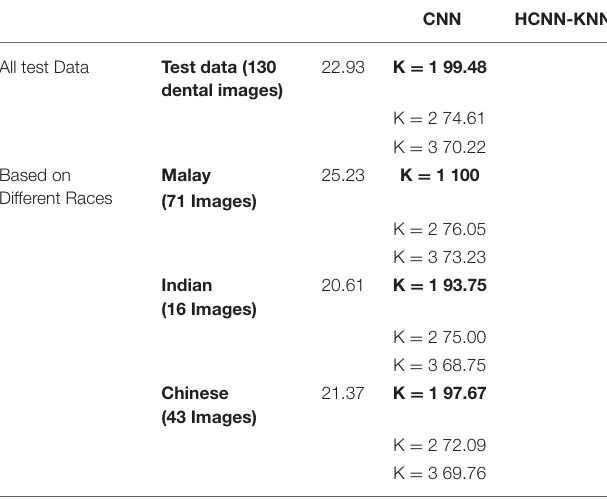
TABLE 6 | Accuracy Result of the Proposed HCNN-KNN Model on Test New Dataset.